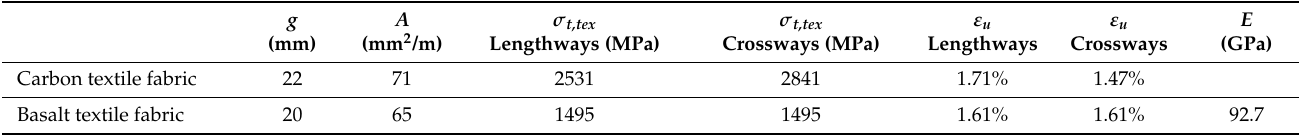
Table 3. Mechanical and geometrical properties of textile